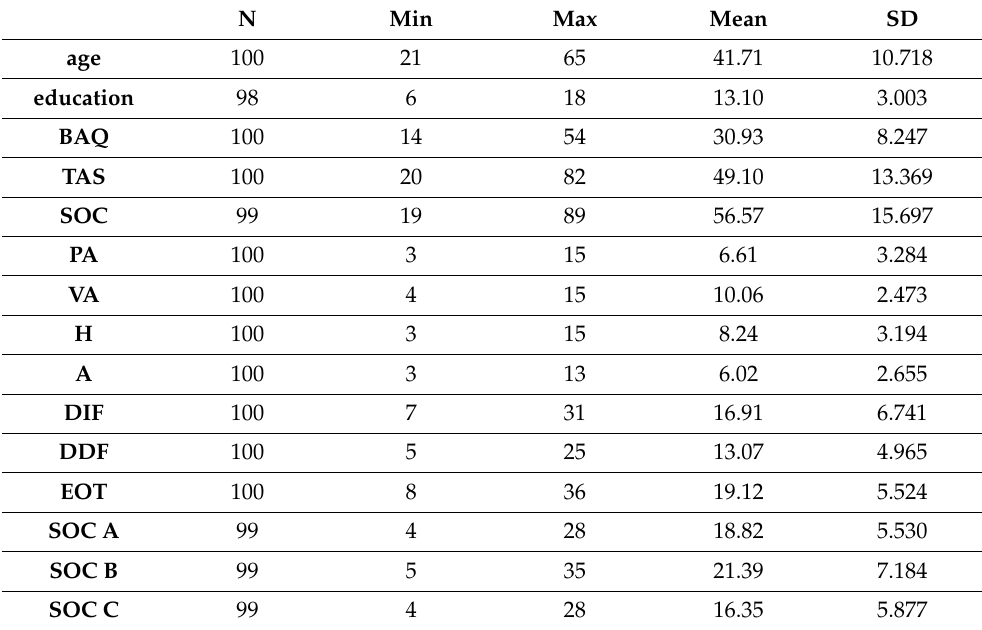
Table 1. General characteristics of participants and scores on BAQ, TAS, SOC and